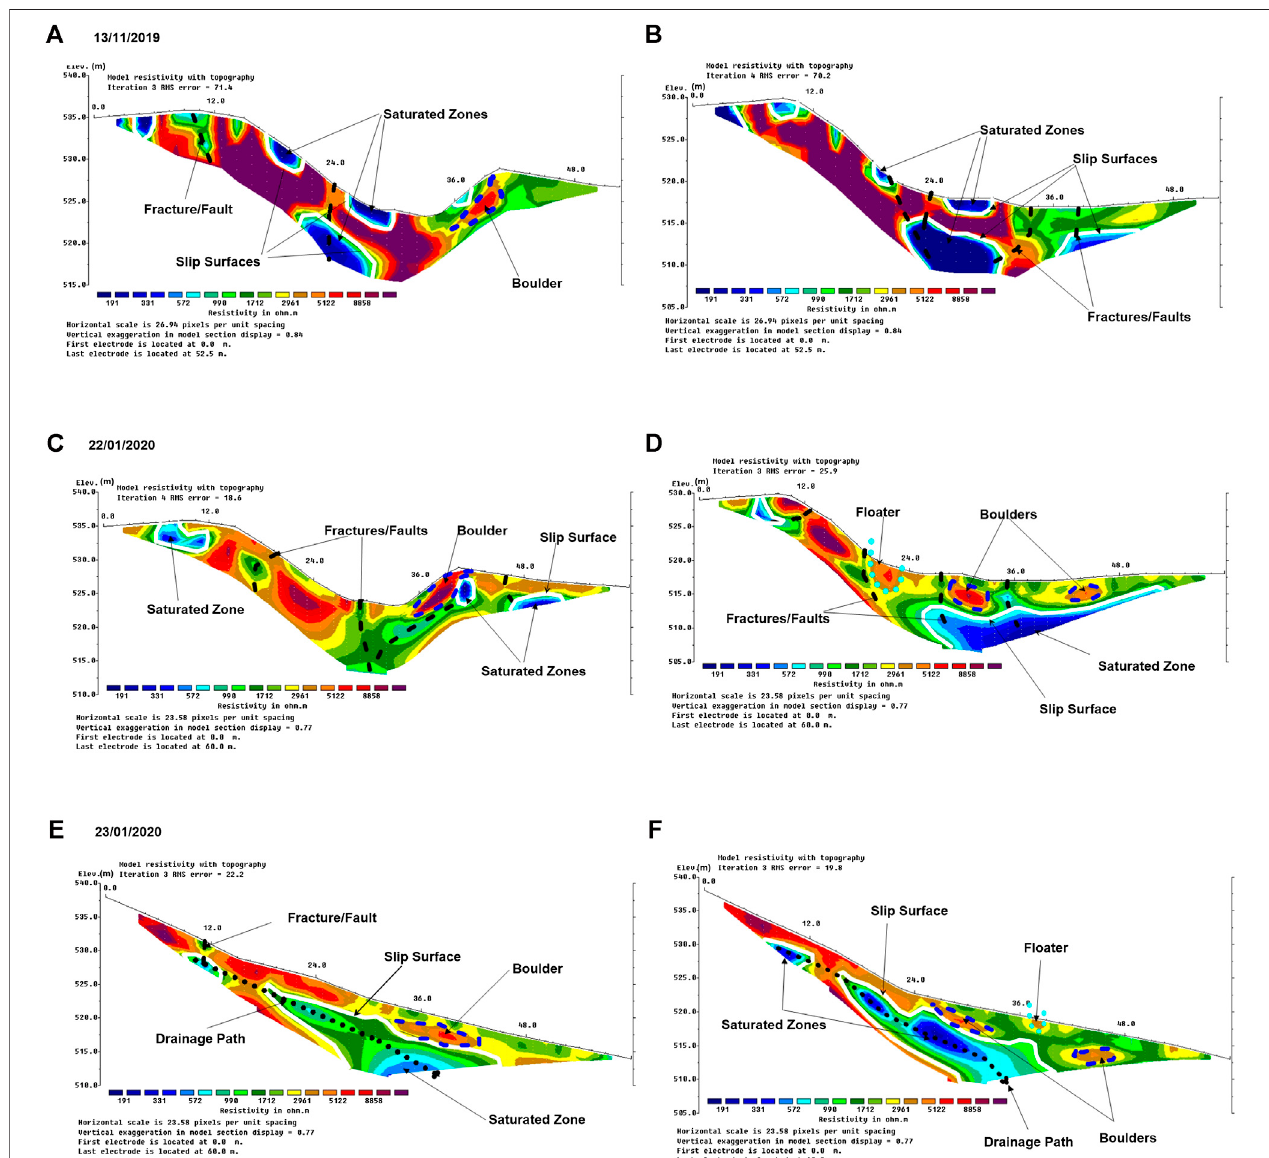
FIGURE 9 | Electrical resistivity tomography model interpretation of the acquired data at different dates using Wenner – Schlumberger array: (A,B) pro fi les in east – west direction on November 13, 2019; (C,D) pro fi les in east – west direction on January 22, 2020, and (E,F) pro fi les in north – south direction on January 23, 2020.